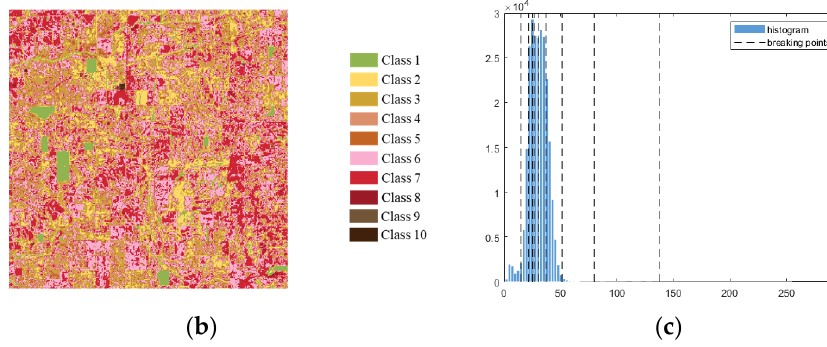
Figure 10. GIC classification results of the Landsat 8 RGB composite. Euclidean norm of the composite ( a ), classification map ( b ), and corresponding breakpoints shown in the histogram ( c ).